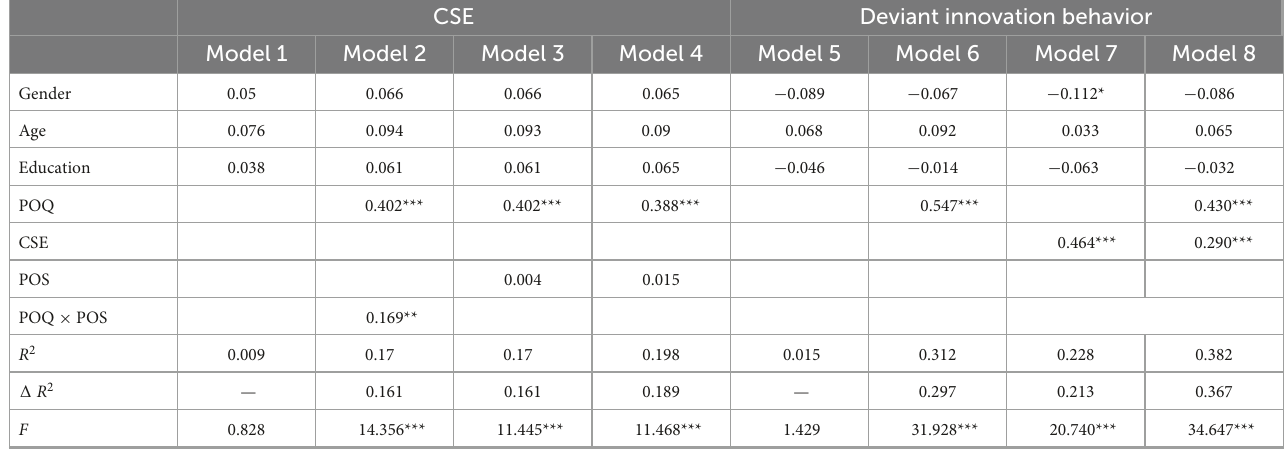
TABLE 4 Results of hierarchical multiple regression analysis.